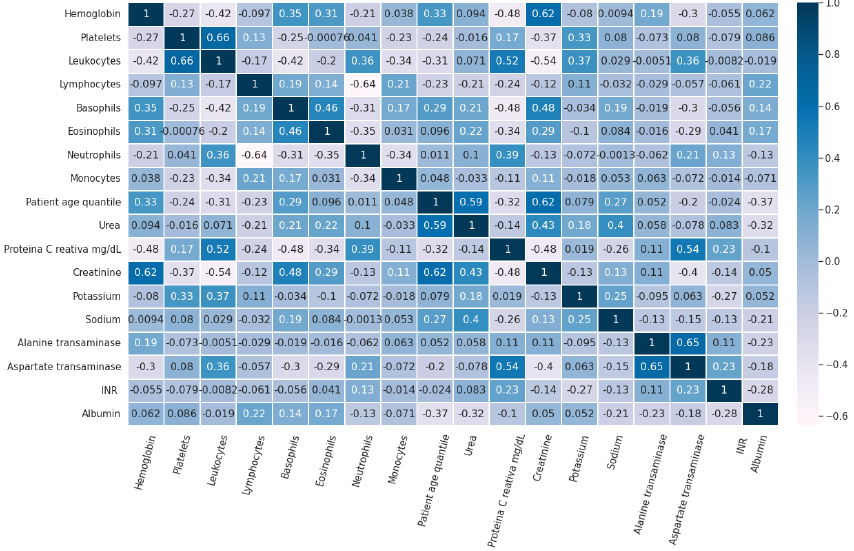
Figure 3. Pairwise Pearson correlation of the features in Dataset